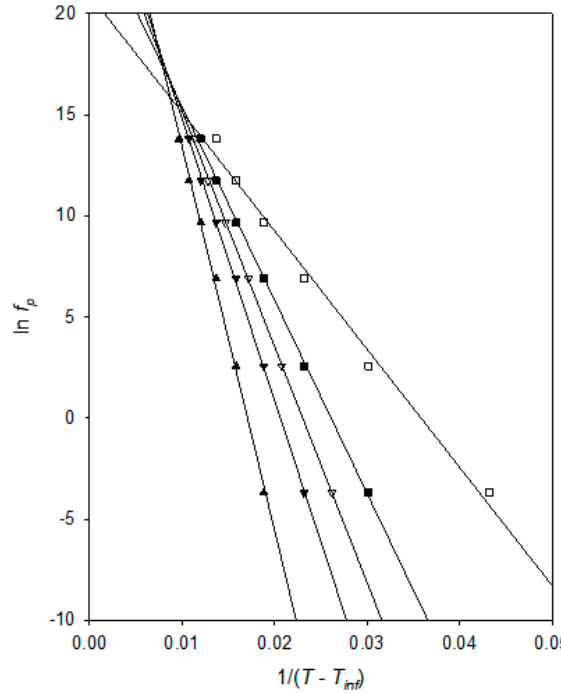
Figure 7. Analysis of the temperature dependence of the higher temperature dielectric relaxation of the rubbery epoxy system: T VFT α = 160 K  ; T VFT α = 170 K  ; T VFT α = 175 K  ; T VFT α = 180 K  ; T VFT α the rubbery epoxy system: T VFT α = 160 K (cid:78) ; T VFT α = 170 K (cid:72) ; T VFT α = 175 K (cid:53) ; T VFT α = 180 K (cid:4) ; = 190 K  . T VFT α = 190 K (cid:3)